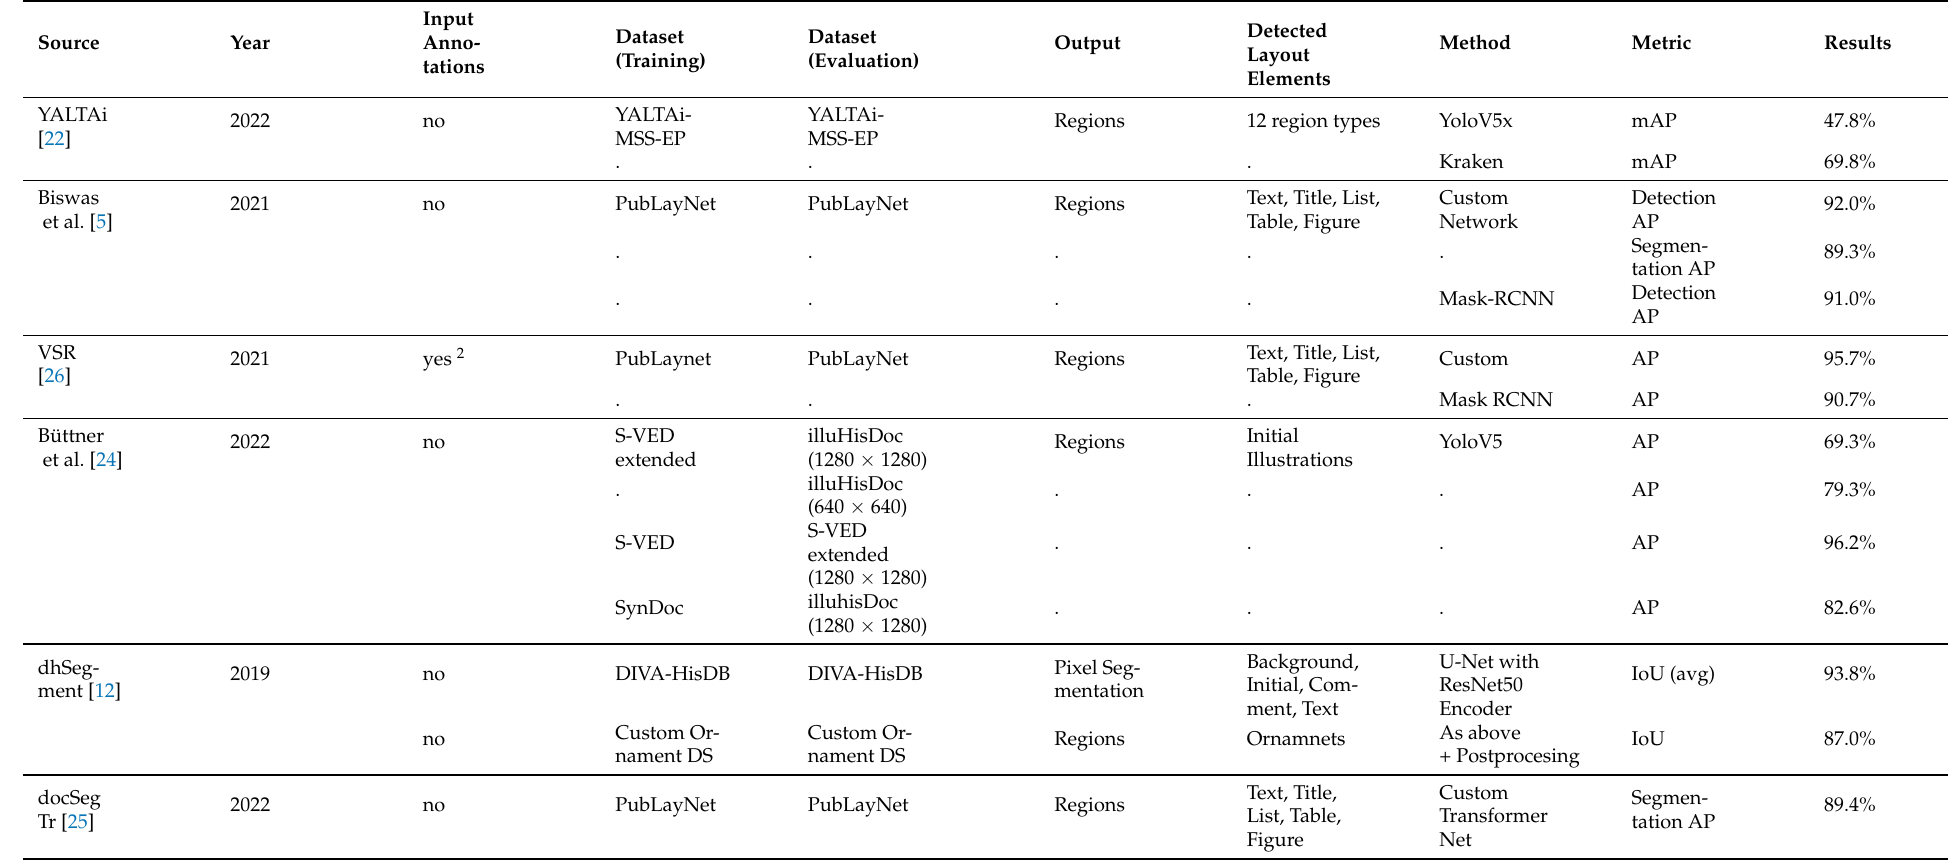
Table 1. Comparison of different layout analysis methods. The training and evaluation datasets, as well as the output of the methods are given in the figure. The evaluated layout elements, the metrics used for evaluation, as well as the results are presented. In addition, some relevant results for comparison architectures are given. Lines with dots indicate the same entry as above. 1 A preprocessed document with physical layout annotations and OCR was used as the input. 2 Character and sentence embedding maps were used as an additional input. * Values have been averaged from the original source’s